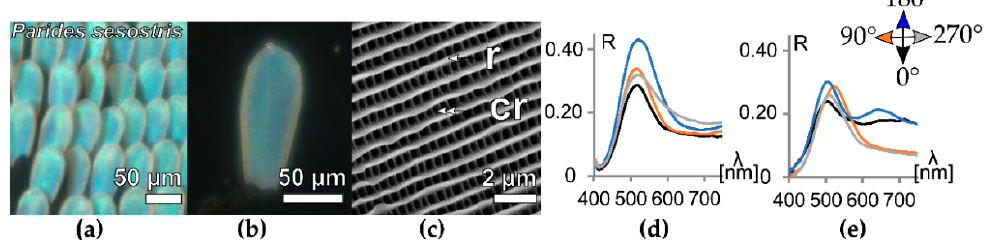
Figure 4. 3D photonic crystal reflectors of Parides sesostris . Panel ( a ) shows an optical micrograph of the scales on the wing, panel ( b ) displays an optical micrograph of a single wing scale. Panel ( c ) shows an SEM image of the scale’s ultrastructure in top-view. The chart at position ( d ) displays the orientation-dependent reflectance of the wing patch and at panel ( e ) the chart represents the orientation-dependent reflectance of the single scales. The SEM image was reproduced here with permission [33], Royal Society Publishing, 2013. In panel ( c ), r marks the scale ridges and Cr marks the cross-ribs. In ( d , e ), R represents reflectance and λ represents wavelength.